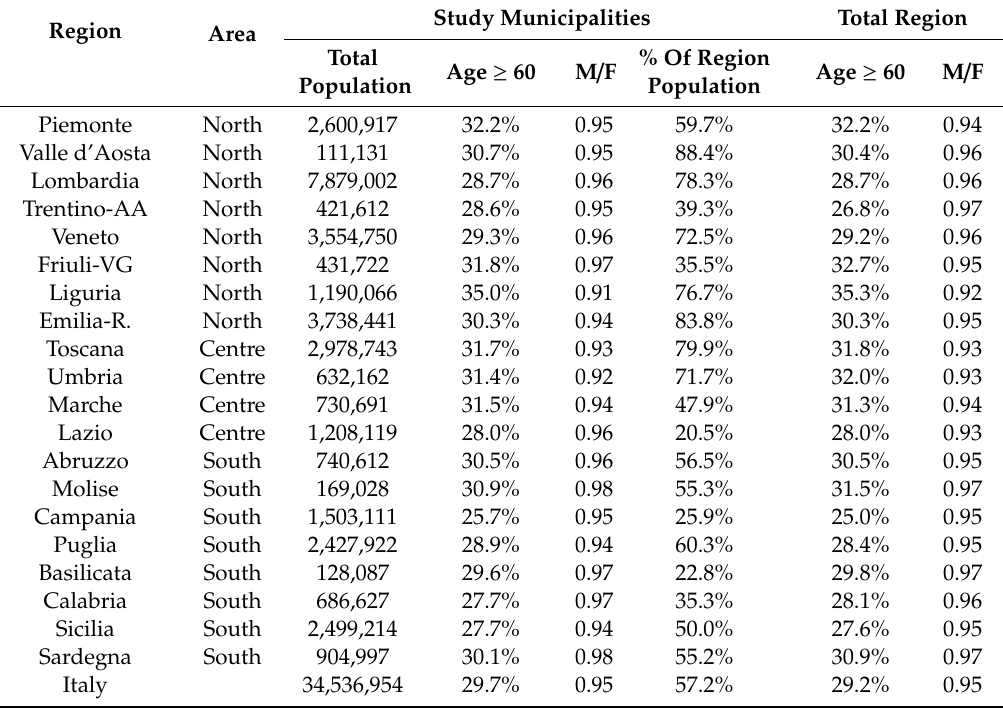
Table 1. Descriptive data on the study municipalities and the corresponding